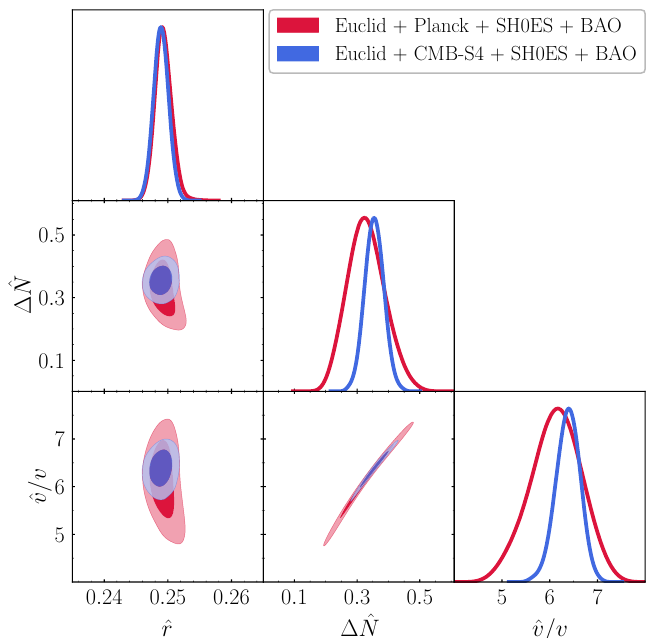
ˆ N , and ˆ v/v obtained using the Euclid